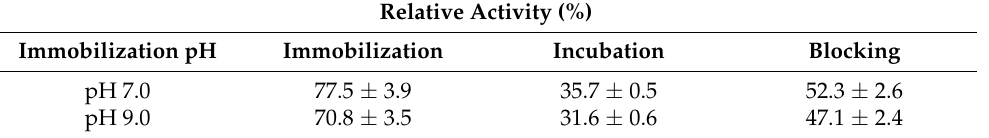
Table 2. Effect of the immobilization pH on the relative activity of different PGA biocatalysts in the different steps of the immobilization process. Biocatalysts were immobilized in 5 mM of sodium phosphate at pH 7.0 or sodium carbonate at pH 9.0. Incubation was carried out in 25 mM of sodium carbonate at pH 8.0 (100 mM of phenyl acetic acid and 30 mM of glycerol) for 3 h and the blocking was carried out utilizing 2 M of glycine at pH 8.0. The experiments were conducted as described in the Methods Section.